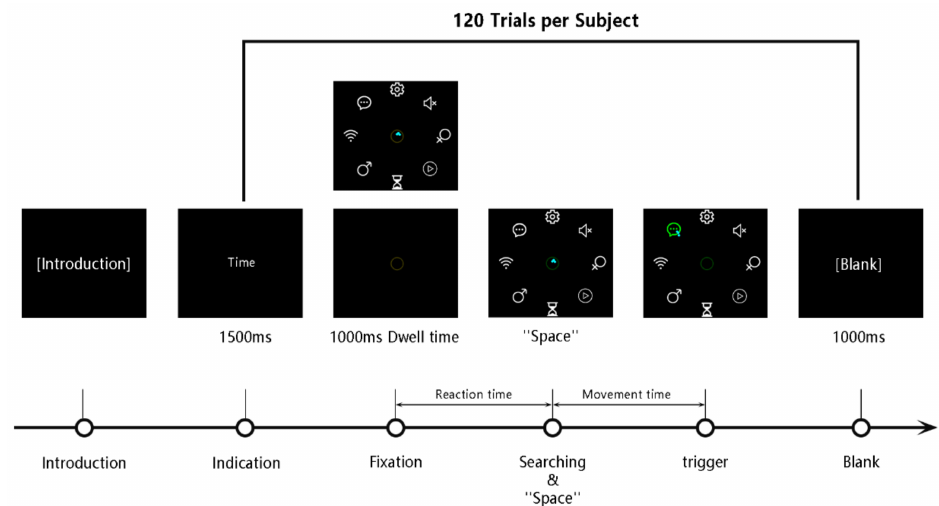
Figure 6. Flow chart of